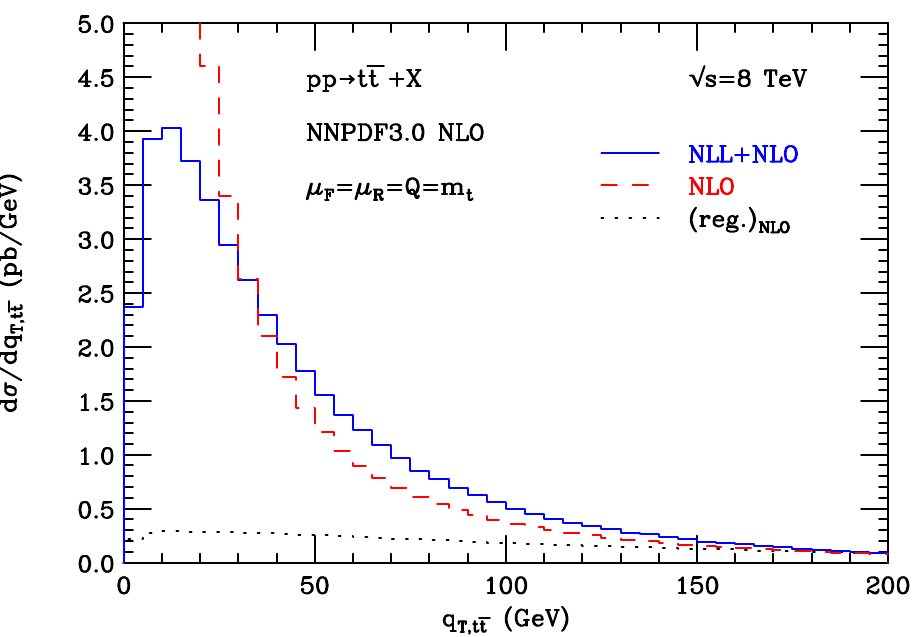
Figure 4. The transverse-momentum cross section dσ/dq T of the t ¯ t pair at the LHC ( √ s = 8 TeV) computed through resummation at NLL+NLO accuracy (blue solid). The resummed result at central scales ( µ R = µ F = Q = m t ) is compared to the corresponding NLO result (red dashed). The contribution of the regular component (black dotted) to the NLL+NLO result is also